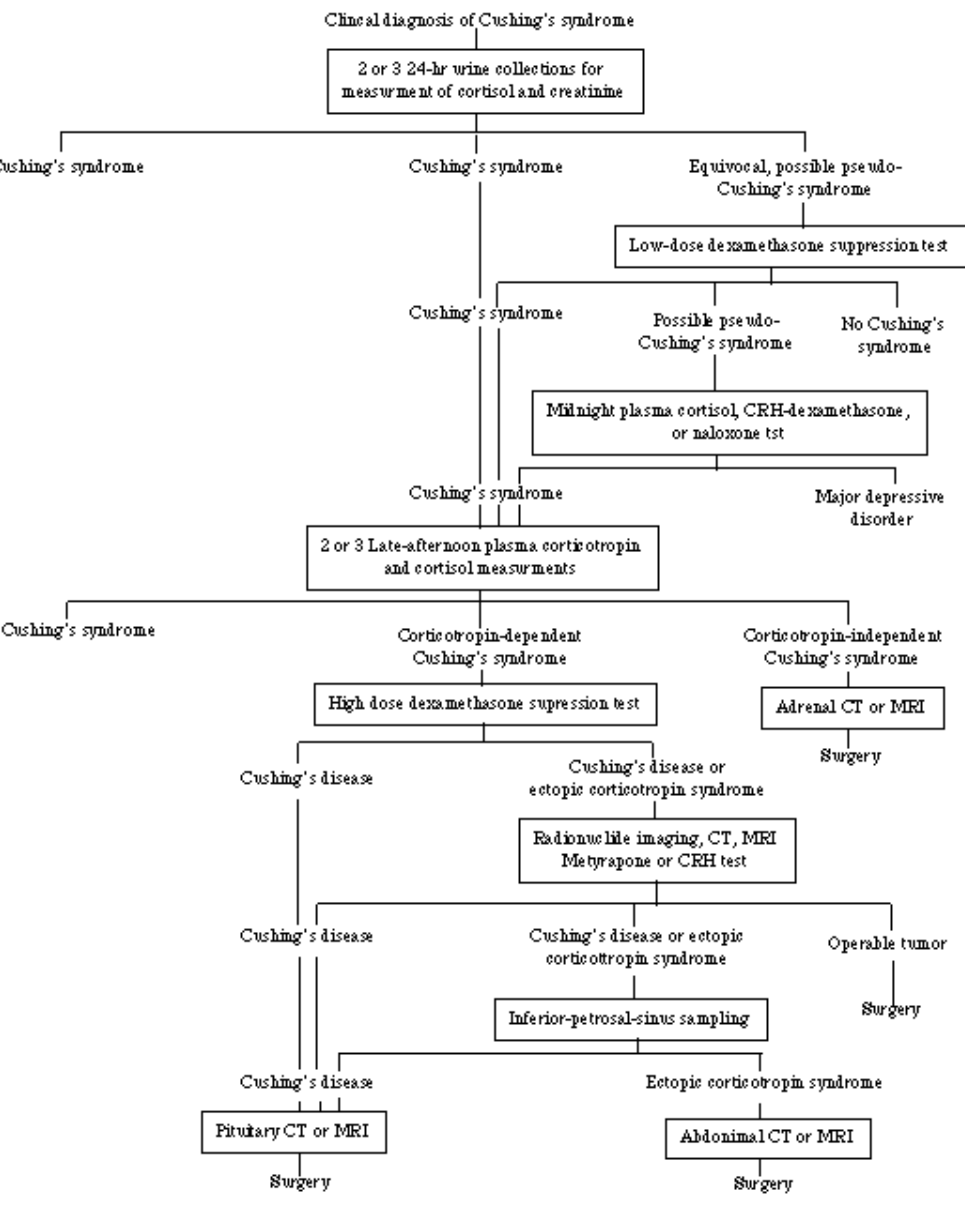
FIGURE 3 . (From: Orth DN: Cushing's Syndrome. N Eng J. Med., 32:791,